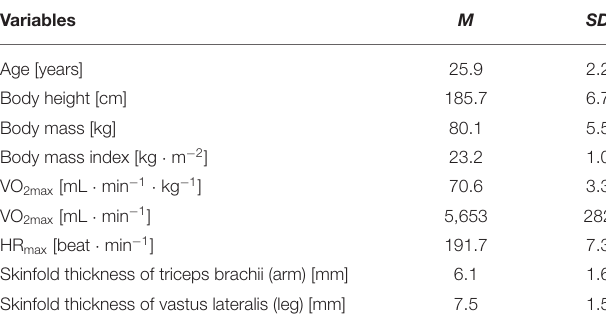
TABLE 1 | Anthropometric, physiological, and performance characteristics ( M ± SD ) of the nine male skiers in the study. Variables